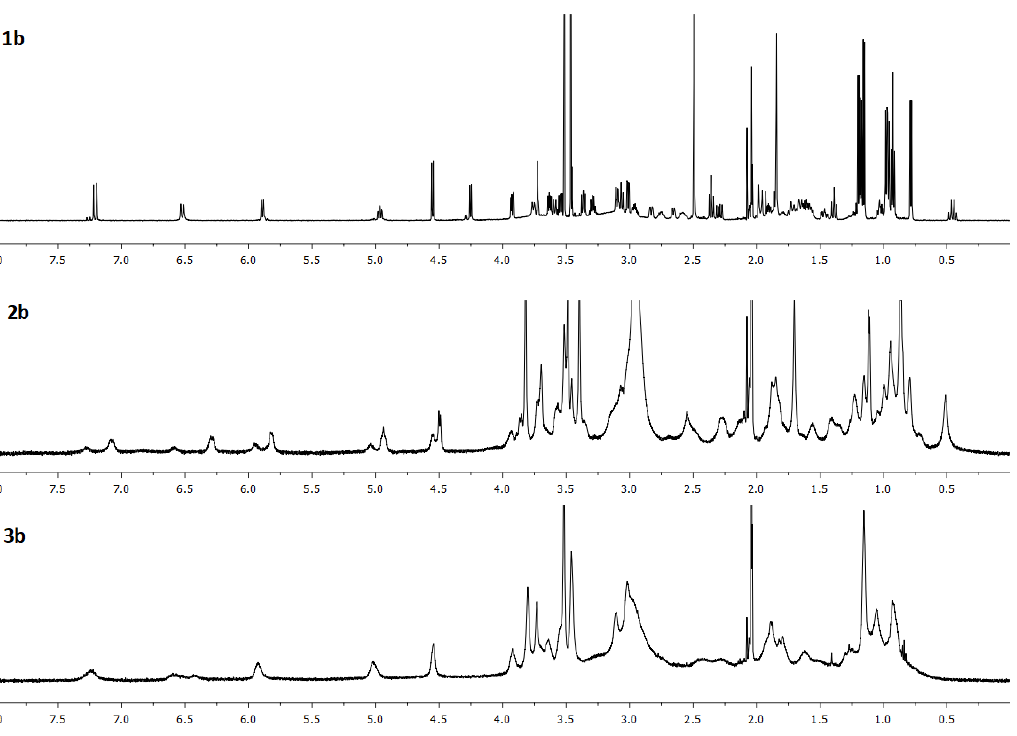
Figure 6. 1 H-NMR spectra of tilmicosin base ( 1b ) and complexes 2b – 3b , 10 –2 M, acetone-d 6 .